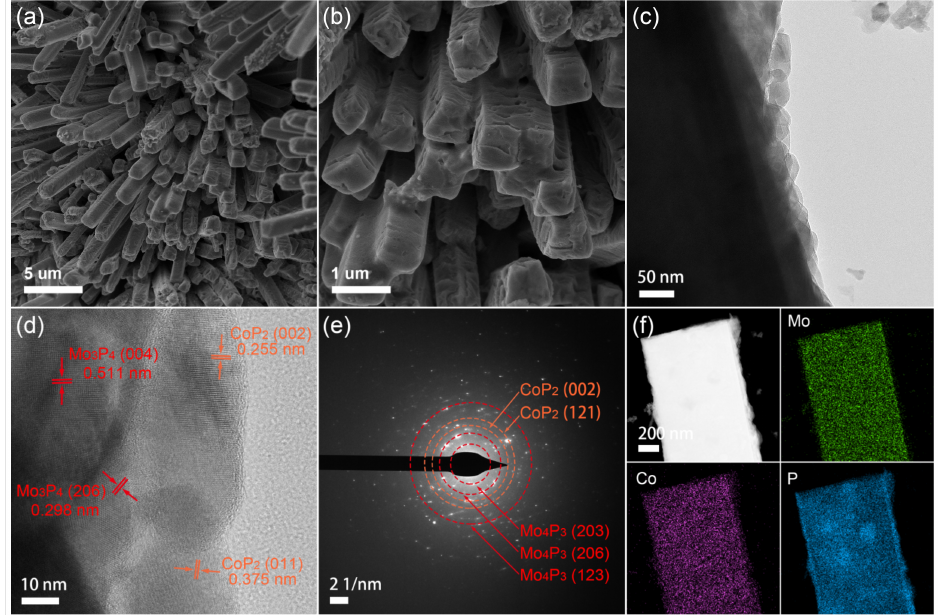
Figure 1. SEM ( a , b ), TEM ( c ), HRTEM ( d ), SAED ( e ) and the corresponding elemental mapping ( f ) images of CoP 2 -Mo 4 P 3 /NF